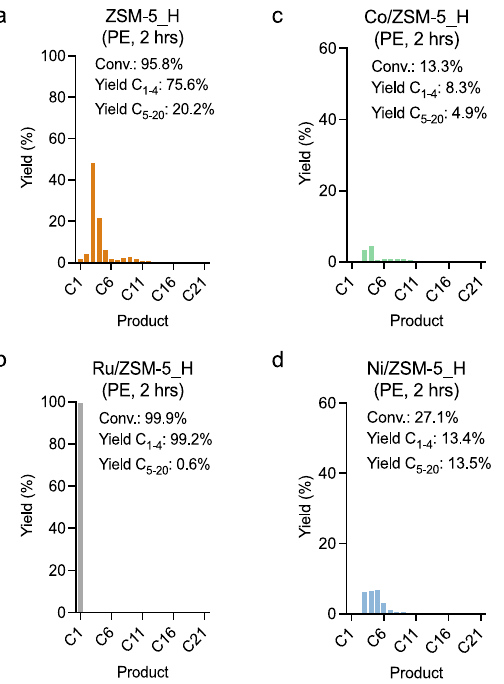
Fig. 4 | Polyethylene (PE) depolymerization under solvent-free and solvent- assisted conditions. a PE (1.59g, ~112mmol of carbon) depolymerization under solvent-free condition: catalyst (0.2g, metal loading=2.5 wt%), 45 bar H 2 , 375°C, 2h via ZSM-5_H, b Ru/ZSM-5_H, c Co/ZSM-5_H, d Ni/ZSM-5_H, e Co/ZSM-5_H, reaction time=16h, f Ni/ZSM-5_H, reaction time=16h. g PE (0.2g, ~14mmol of